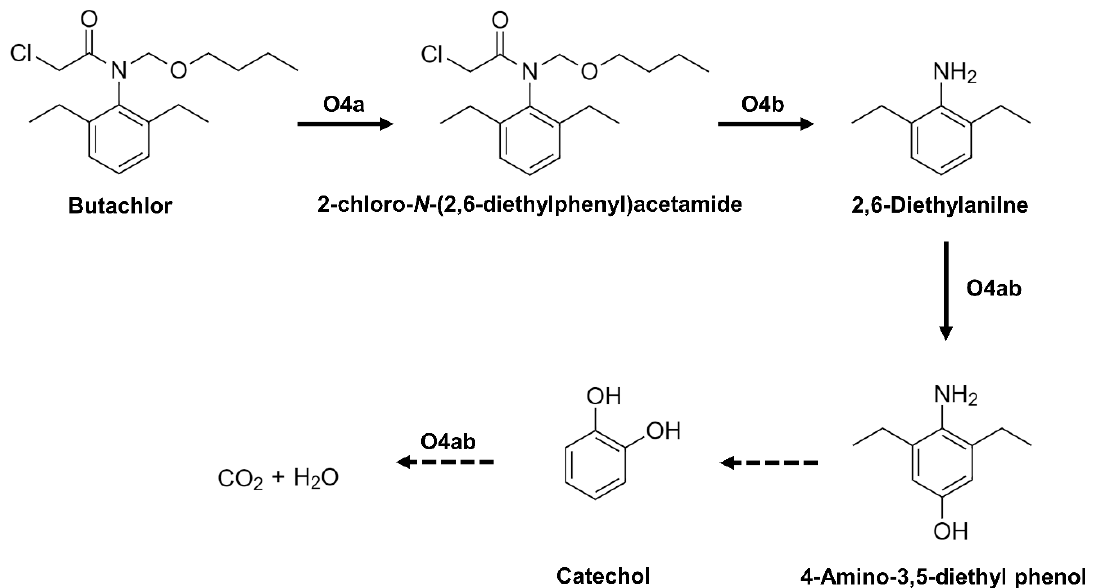
Figure 4. Proposed biodegradation pathway of butachlor by the syntrophic pair O4ab.